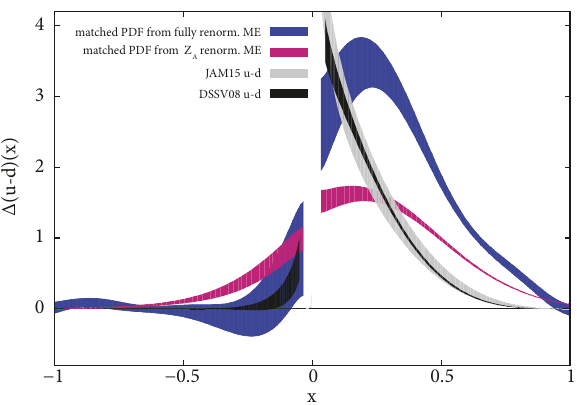
Figure 18: Comparison of lattice estimates of the ETMC’s helicity PDF, properly renormalized (blue band) or renormalized using the local axial current renormalization factor 𝑍 𝐴 (magenta band). For qualitative comparison, phenomenological PDFs (DSSV08 [206] and JAM15 [208]) are also plotted. Source: [151], reprinted with permission by the Authors (article available under CC